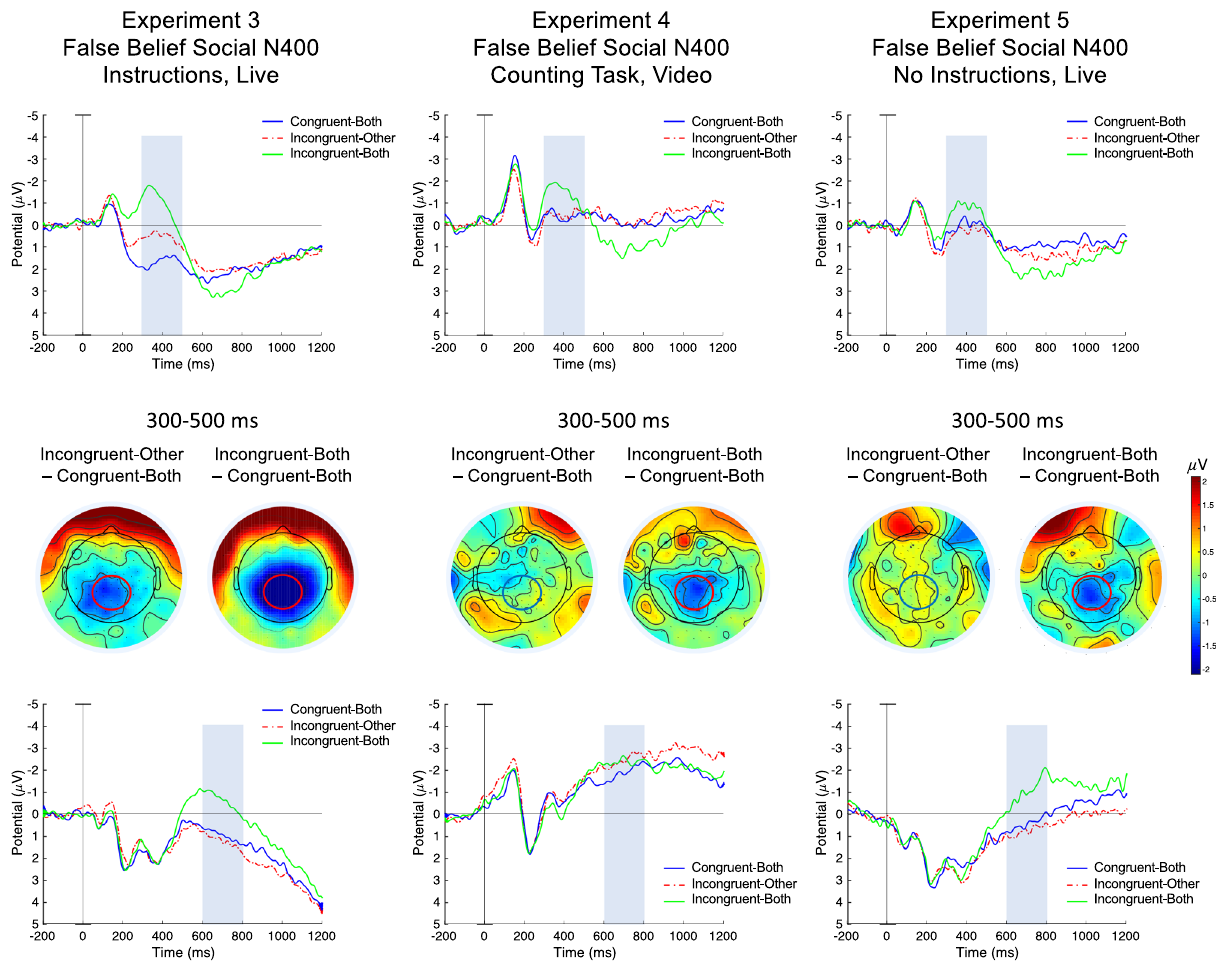
Figure 3. Electrophysiological responses observed in Experiments 3–5, evoked in a false belief social N400 paradigm with or without instructions. Top and bottom panels show grand average ERP responses over the centro-parietal and the frontal ROIs, respectively. Grey shades show time windows where statistical analyses were carried out (300–500 ms centroparietally and 600–800 ms frontally). Time 0 indicates audio word playback onset. Middle panels show topographical difference maps of indicated conditions in the 300-500 ms time window. A social N400 effect (Incongruent-Other–Congruent-Both) is apparent only when explicit instructions directed participants to mark on a response sheet if audio labels were correct from the perspective of an Observer (Experiment 3), but no such effect was evoked when there were no instructions to follow the language comprehension of the Observer (Experiment 4 & 5). Participants did not spontaneously follow the comprehension of a confederate seated facing them in a false belief situation, which suggests that interlocutors might not attend another person’s communicational perspective and mental state, unless explicitly required to do so. Additional late effects were observed and are reported in Supplementary Results (also see